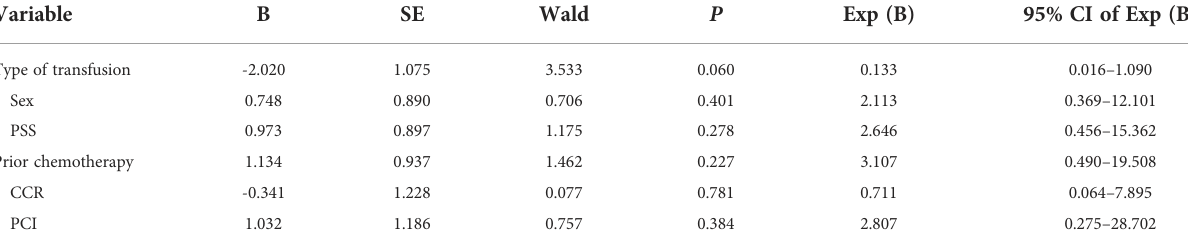
TABLE 3 Cox regression analysis of the factors affecting the postoperative survival. Variable